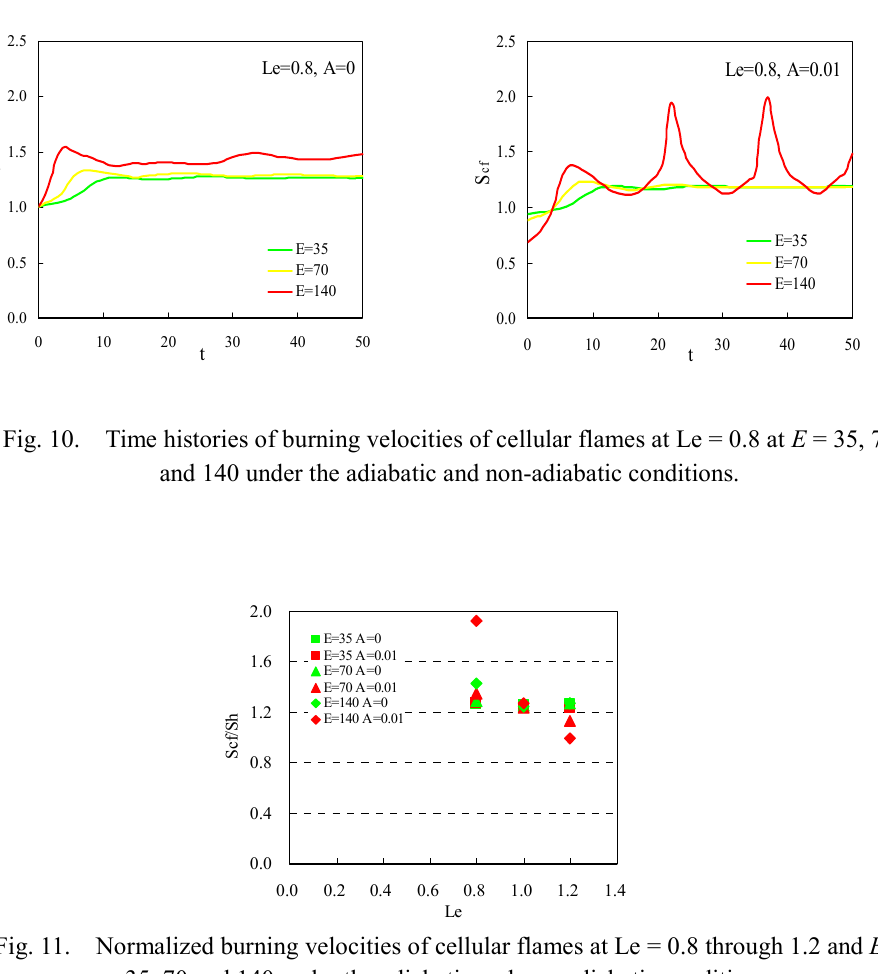
The burning velocity of a cellular flame is normalized by that of a planar flame. The normalized burning velocities of cellular flames at Le = 0.8, 1.0 and 1.2, and E = 35, 70 and 140 under the adiabatic and non-adiabatic conditions are shown in Fig. 11.